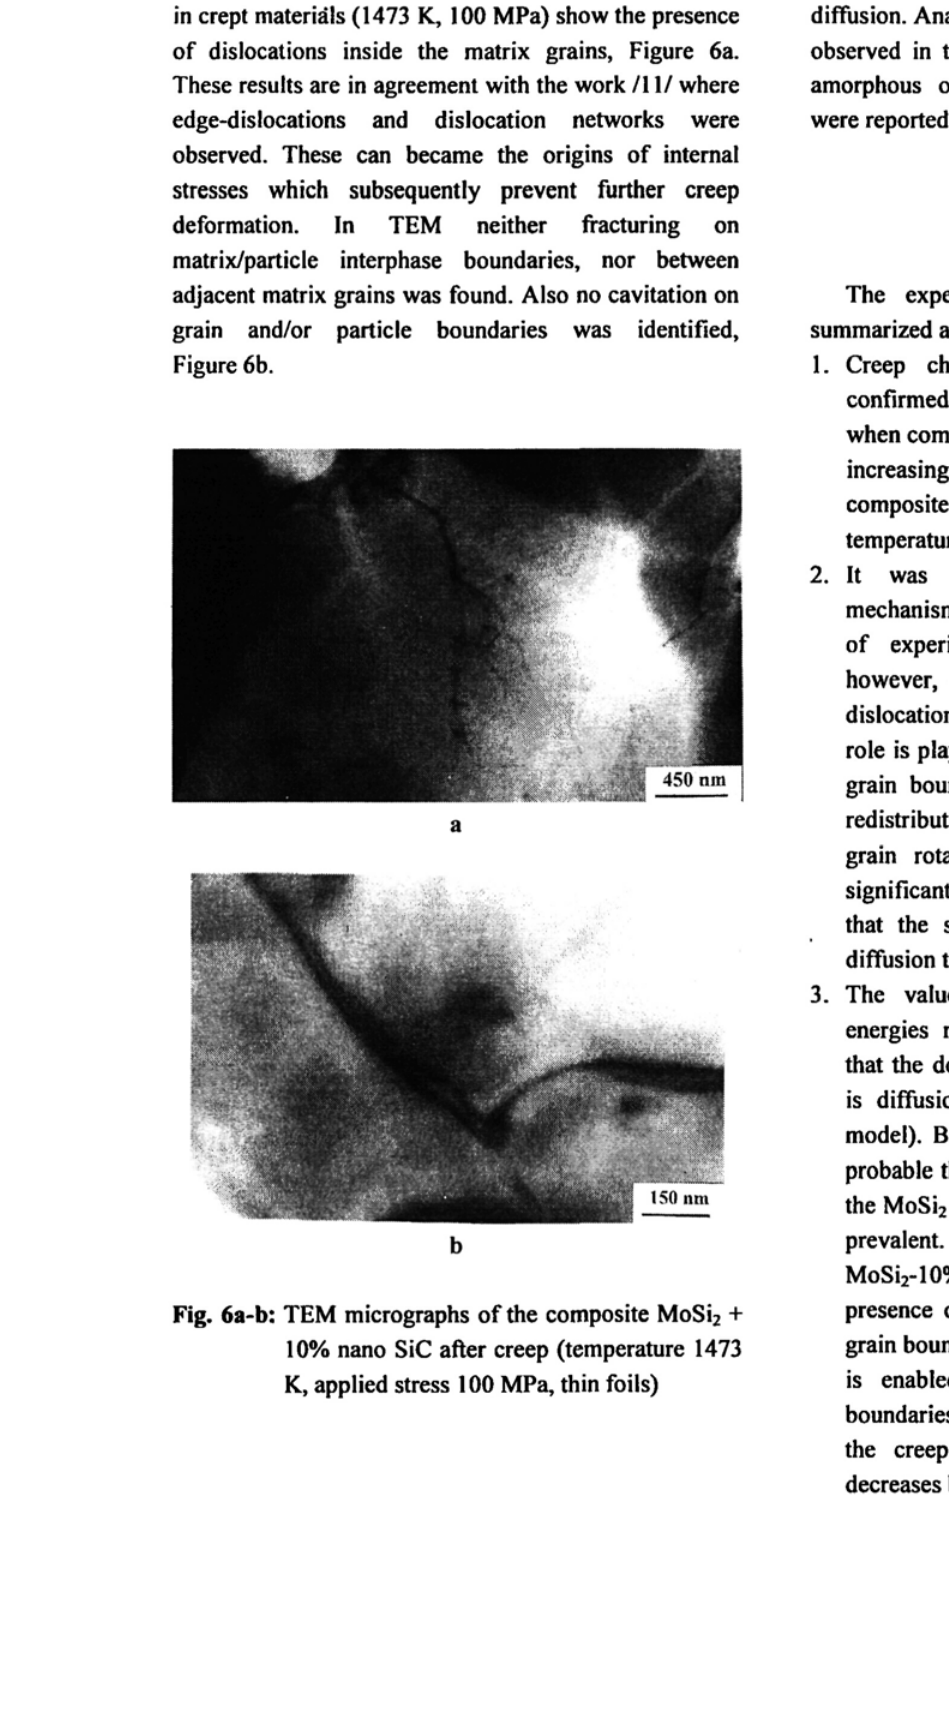
Fig. 6a-b: TEM micrographs of the composite MoSi 10% nano SiC after creep (temperature 1473 K, applied stress 100 MPa, thin